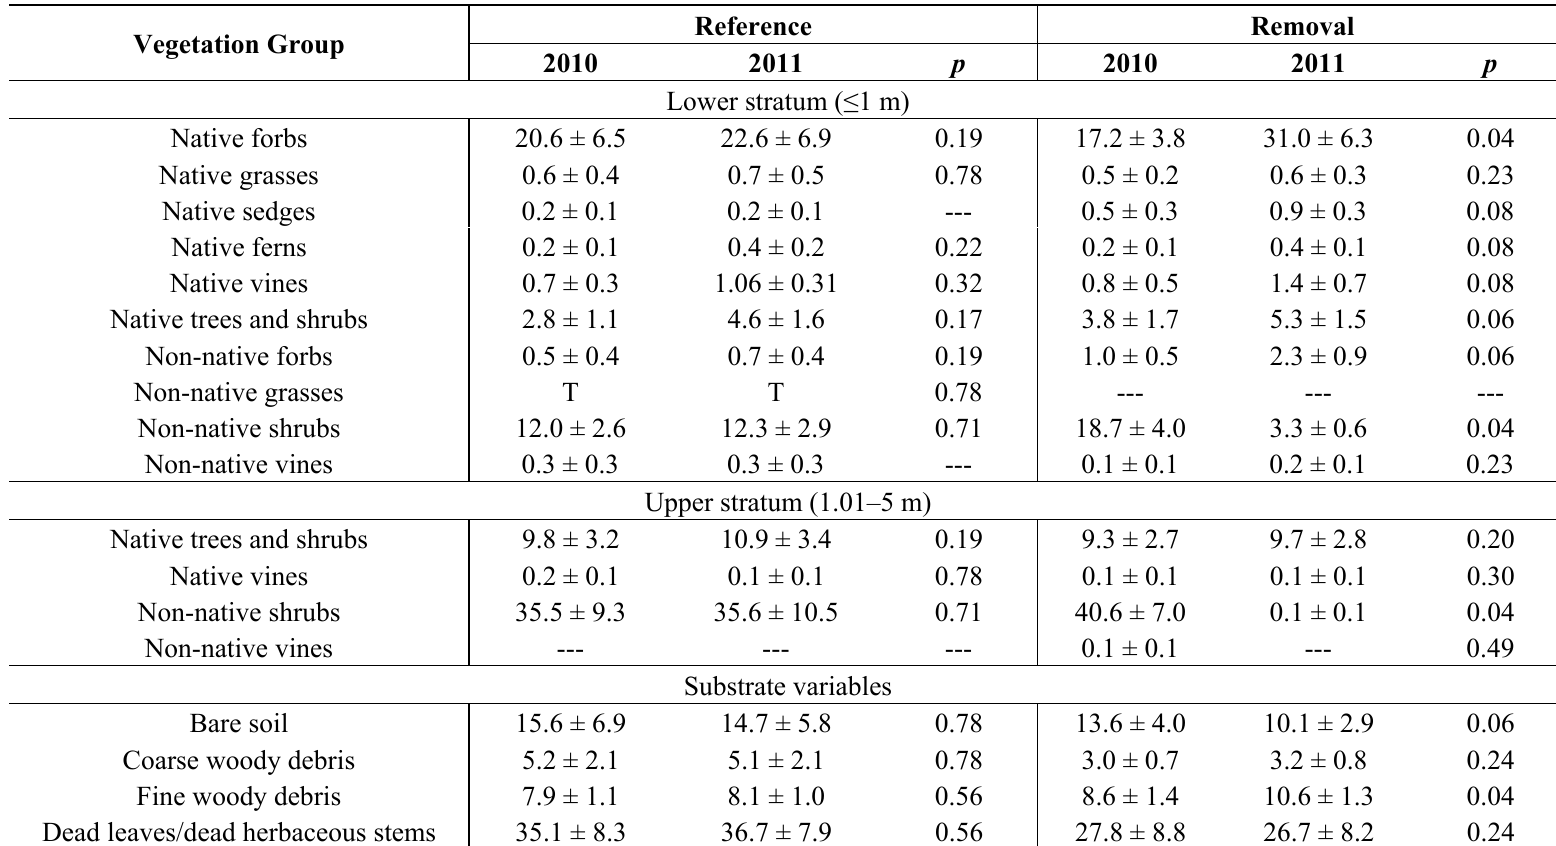
Table 2. Mean percent cover (±1 SE) and Wilcoxon signed rank test results for native and non-native plants (grouped according to growth habit) and substrate variables in reference and removal areas, during the spring seasons of 2010 and 2011 at six mixed-hardwood forests in central Indiana. Although mean values are presented, Wilcoxon p values were calculated to examine significance of differences between 2010 and 2011, based on ranks. For each group/substrate variable, mean values were calculated from the six study sites ( n = 6 for each species in a given treatment type, year, and season). Plant data were collected in the lower stratum ( ≤ 1 m) and upper stratum (1.01–5 m) whereas substrate data were collected only in the lower stratum. p -values were adjusted for multiple comparisons with a graphically-sharpened procedure to control the false discovery rate [35]. Adjustments were made separately for reference and removal areas. T = trace (<0.1%